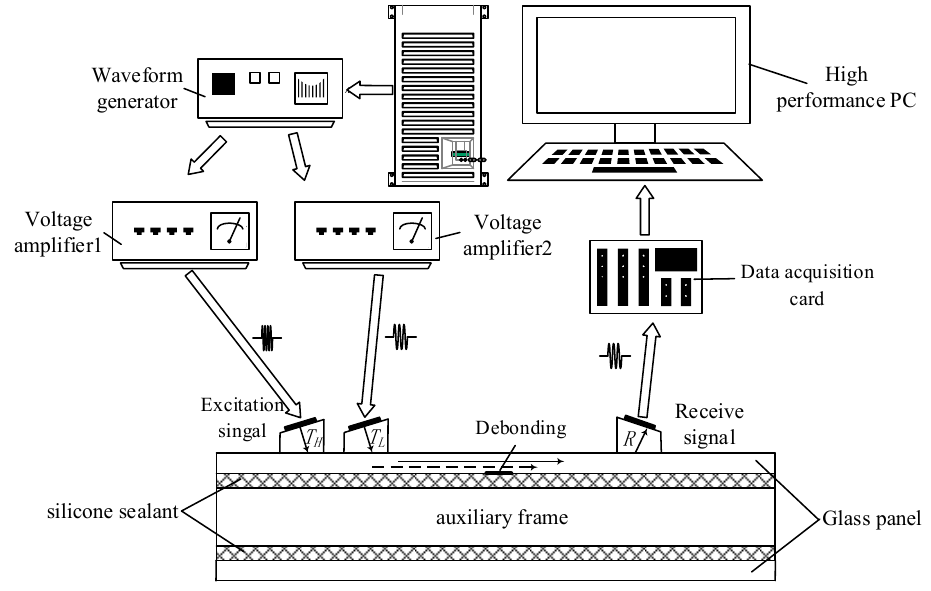
Figure 4. The experimental block diagram of the nonlinear ultrasonic modulation testing method.